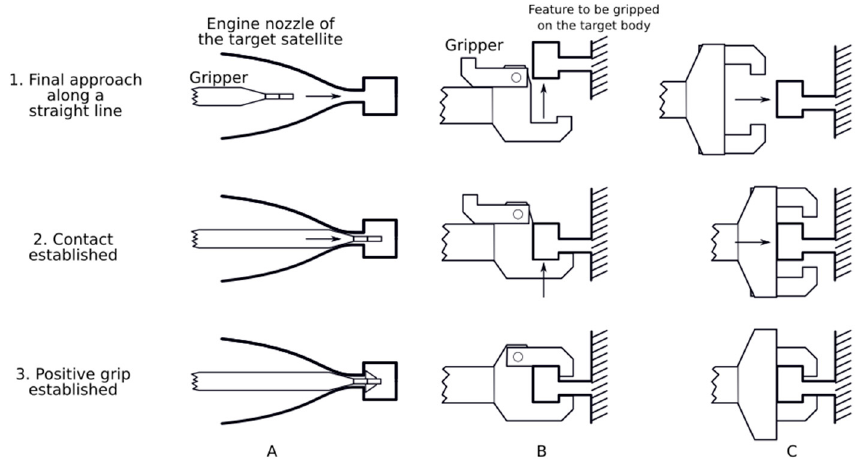
Figure 2. Various gripping strategies for interception of a space object. Dominant direction in each case is shown by the arrow.